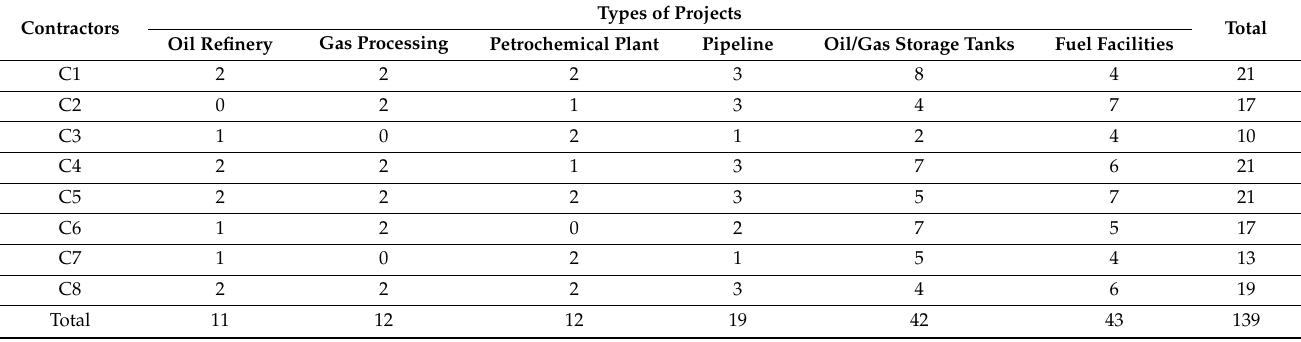
Table 5. Historical data from 139 projects employed to develop and assess the proposed